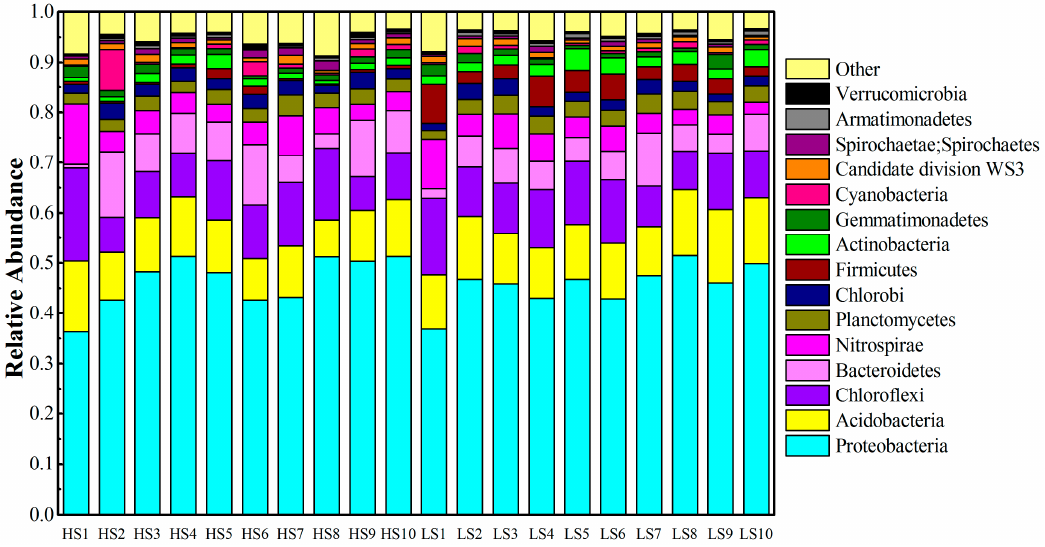
Figure 3. Phylogenetic distribution of sequences assigned on the phylum.